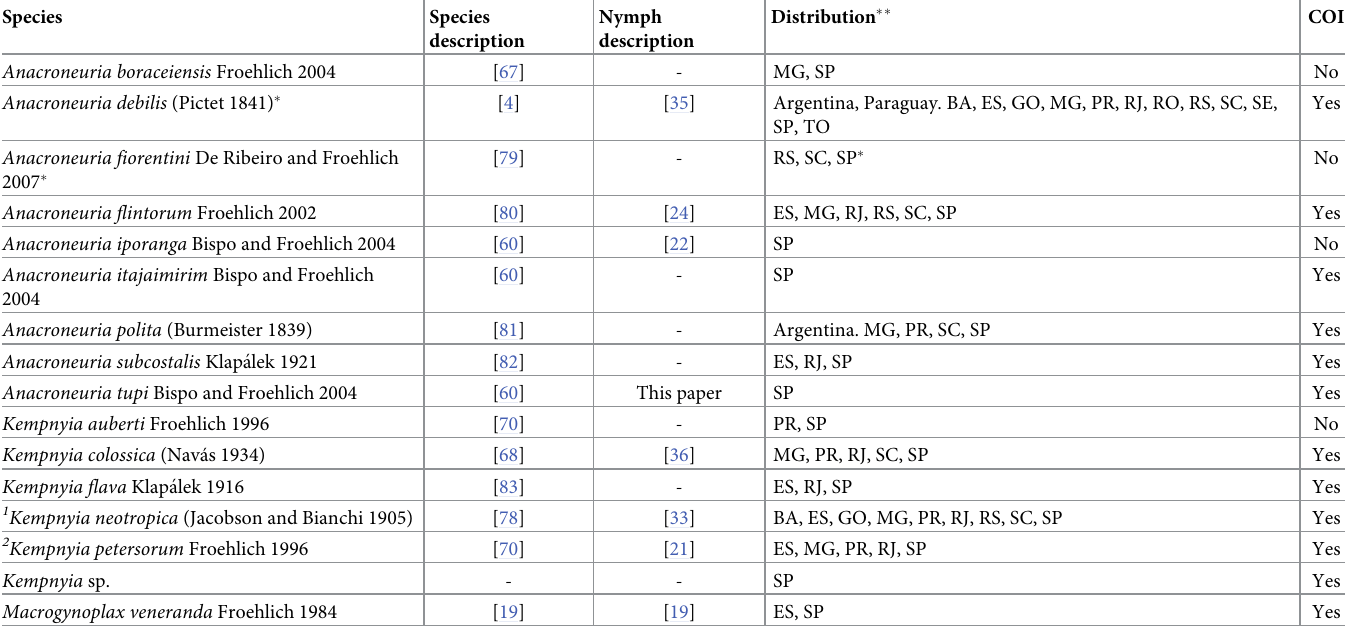
Table 1. Perlidae species recorded in Paranapiacaba Mountains (S ã o Paulo State, Brazil) with known life stages and distribution.